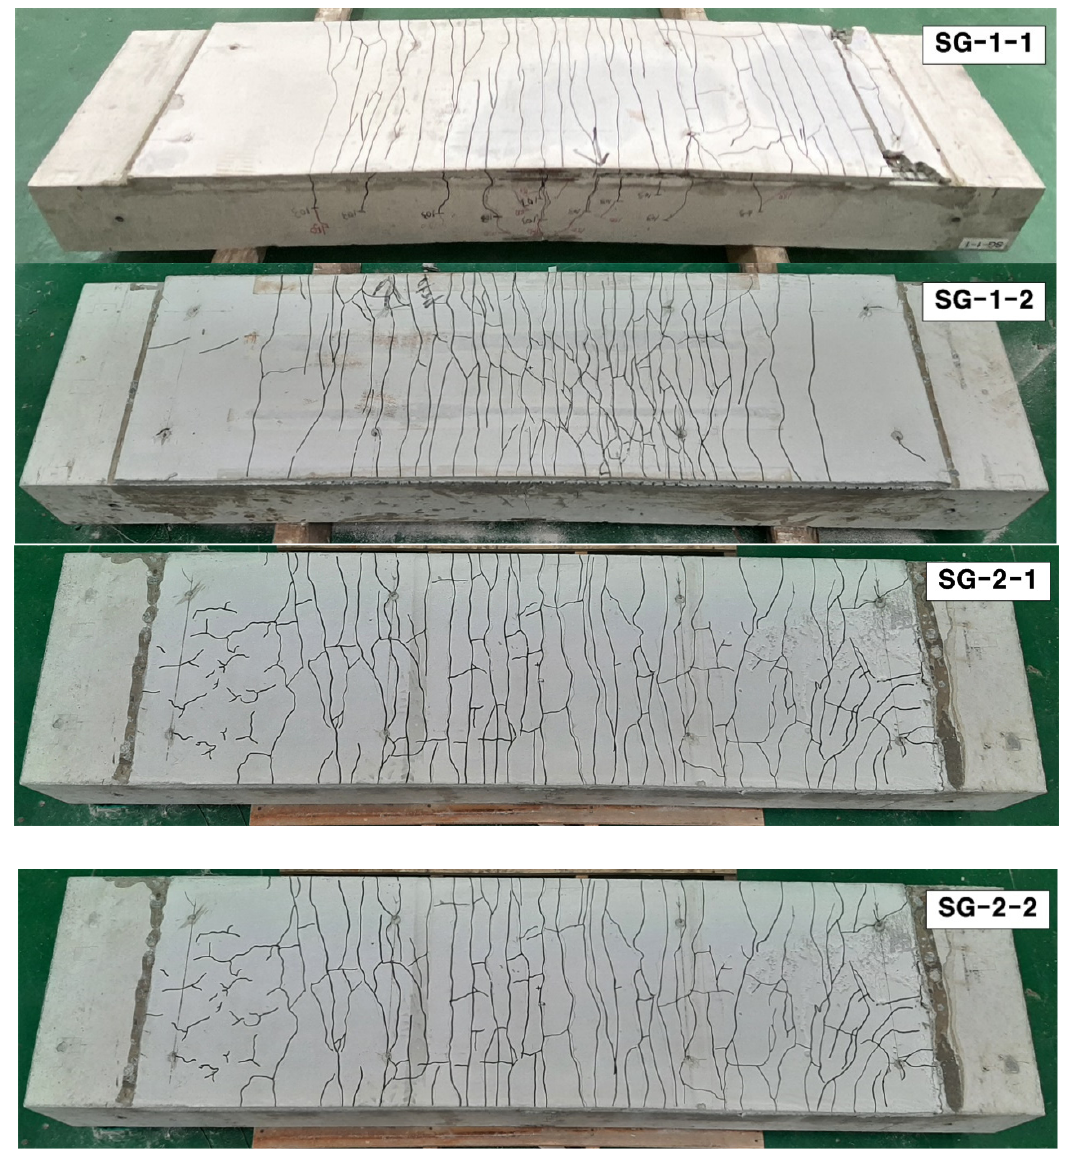
Figure 9. Crack patterns of specimens (side view).